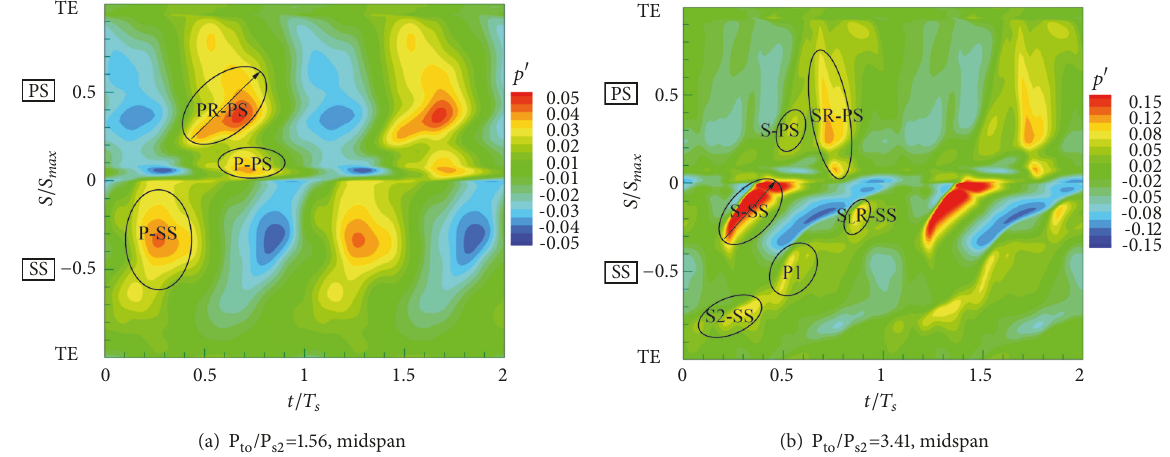
Figure 6: Space-time plots of unsteady pressure at midspan of the rotor blade surface.